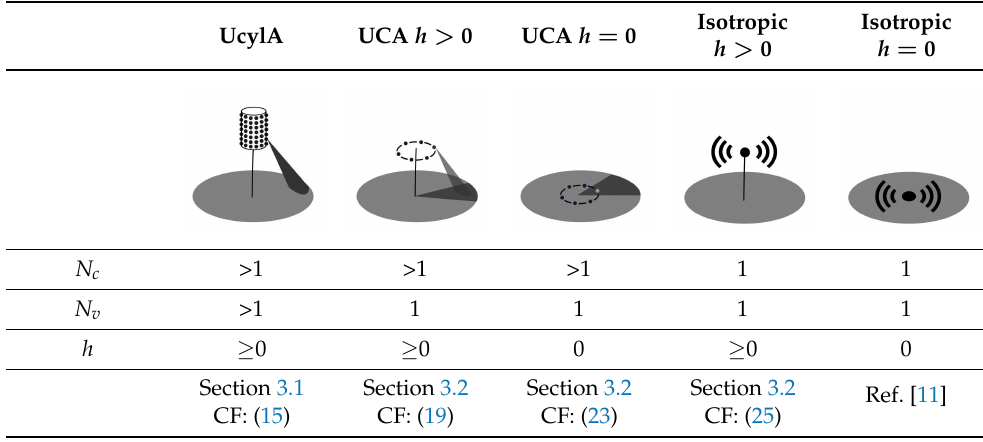
Table 1. Array configurations and reference to the characteristic function (CF) of aggregated interference Ψ ( ω ) = E [ e j ω I ]